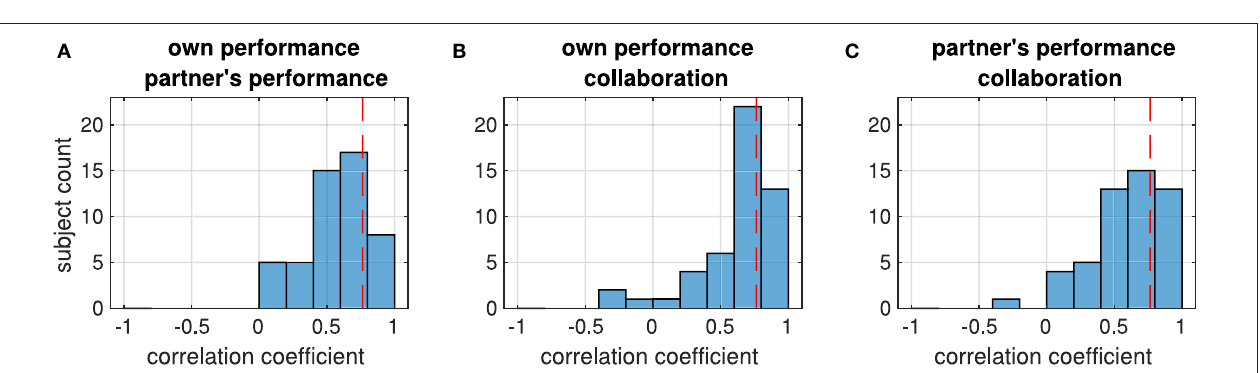
from zero: all p < 1e − 8 , Wilcoxon signed rank test), reaching a significance threshold of p < 0.05 (FDR-corrected) in several subjects ( Figure 4